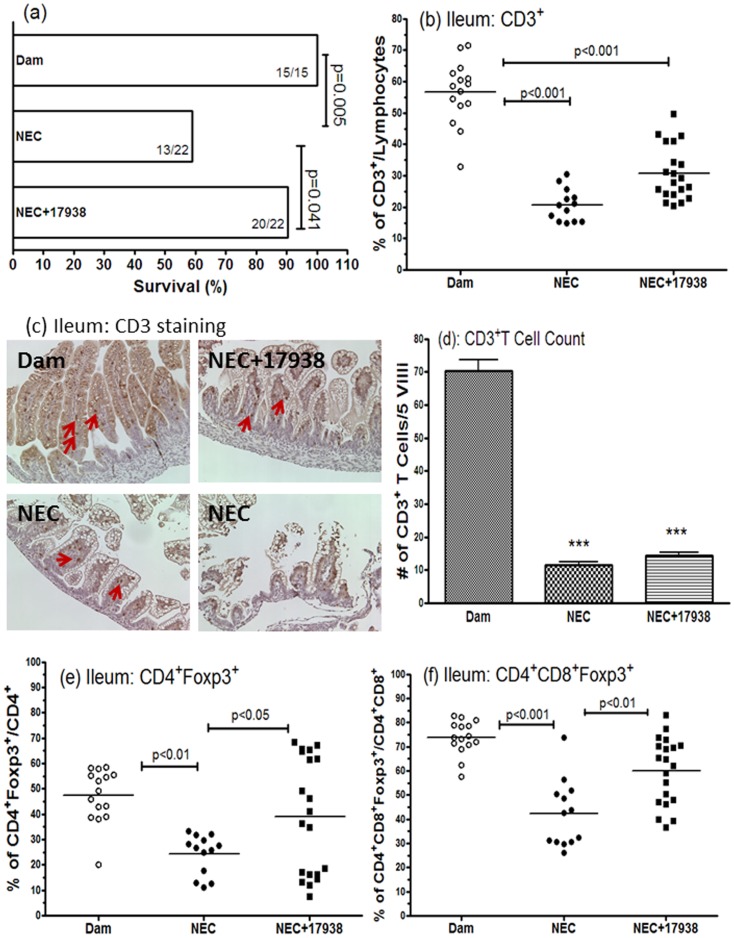
Effect of Lactobacillus reuteri DSM 17938 on survival, CD3+ T cells and Foxp3+ T cells in the ileum of rats with NEC.(a) Survival (%) of different groups of rat pups (dam-fed, NEC, and NEC+17938). (b) Changes of % CD3+ T cells of lymphocytes in different groups. (c) Immunohistochemical staining of CD3+ cells in rat pup ileum, 200 × magnification. (d) Number of CD3+ T cells per 5 villi in IHC. (e) Percentage of CD4+Foxp3+Tregs in each group on day 4 of NEC. (f) Percentage of double positive CD4+CD8+Foxp3+ T cells. The numbers represent percent of T cells (means ± SE). Each dot represents one animal in each group in the figures b, e, and f. Dam-fed: N = 15, NEC: N = 13, NEC+17938: N = 20.